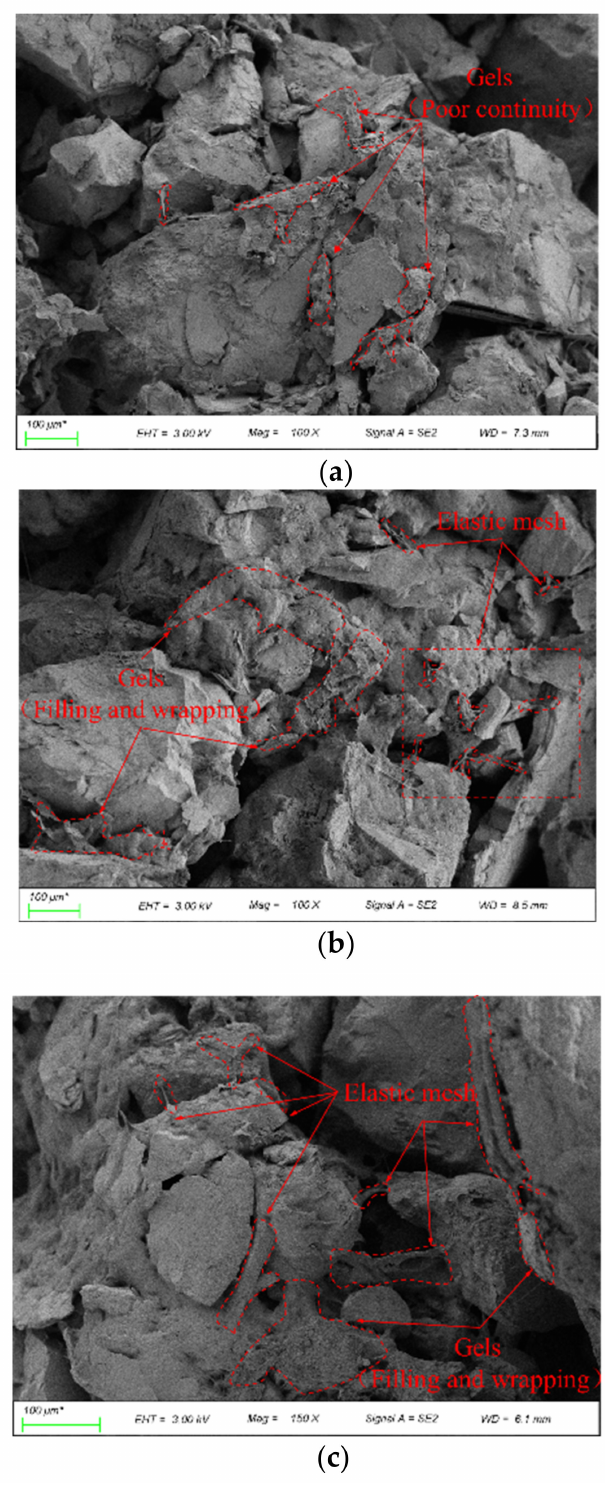
Figure 12. The microstructure of the samples stabilized by PVA solution and silica fume